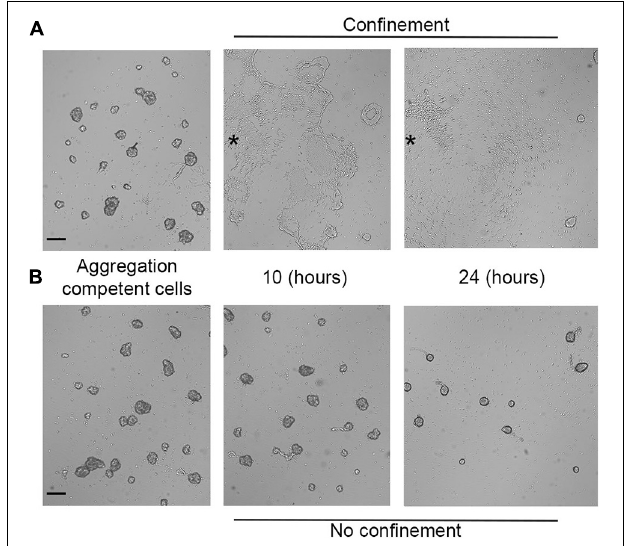
FIGURE 6 | Aerotactic migration of aggregation-competent cells. Photograms taken at different times (7, 10, and 24 h) using a Zeiss Axiovert 200 microscope, with a magnification of 5 × . Aggregates under (A) confinement or (B) no confinement. Scale bar = 200 µ m. Asterisks indicate approximately the center of the cell